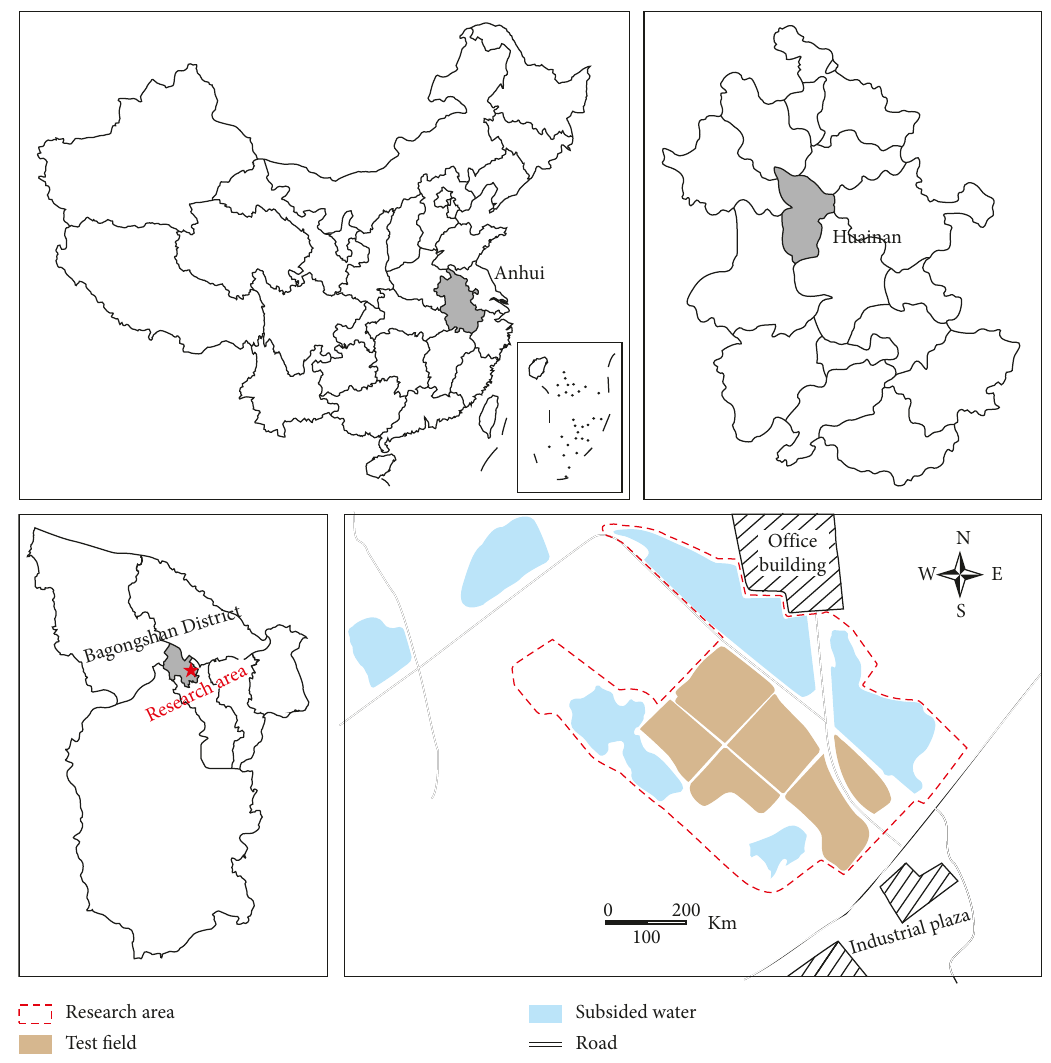
Figure 1: Geographical location of the study area.